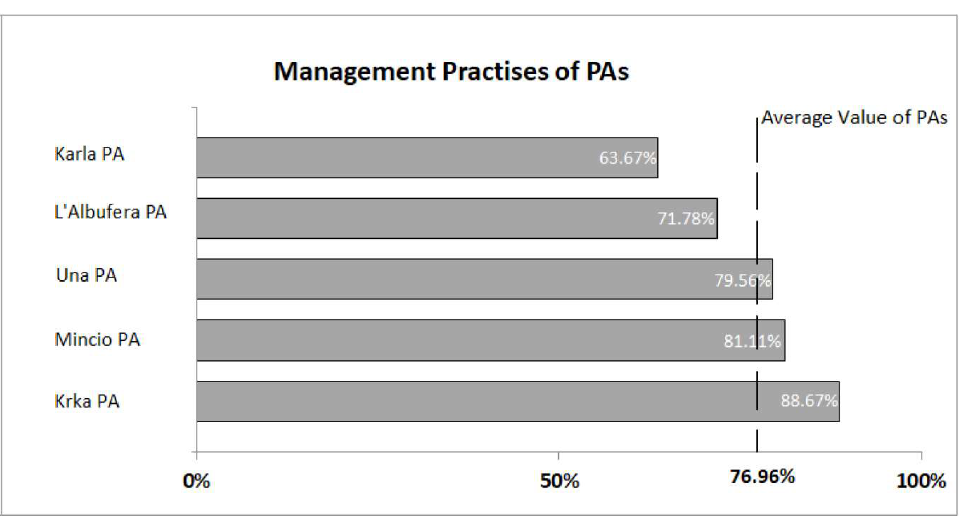
Figure 2. Gap rating on “Management Practices” for each of the five PAs.